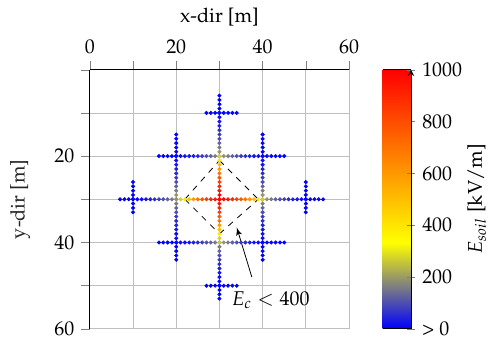
Figure 11. Application case: peak